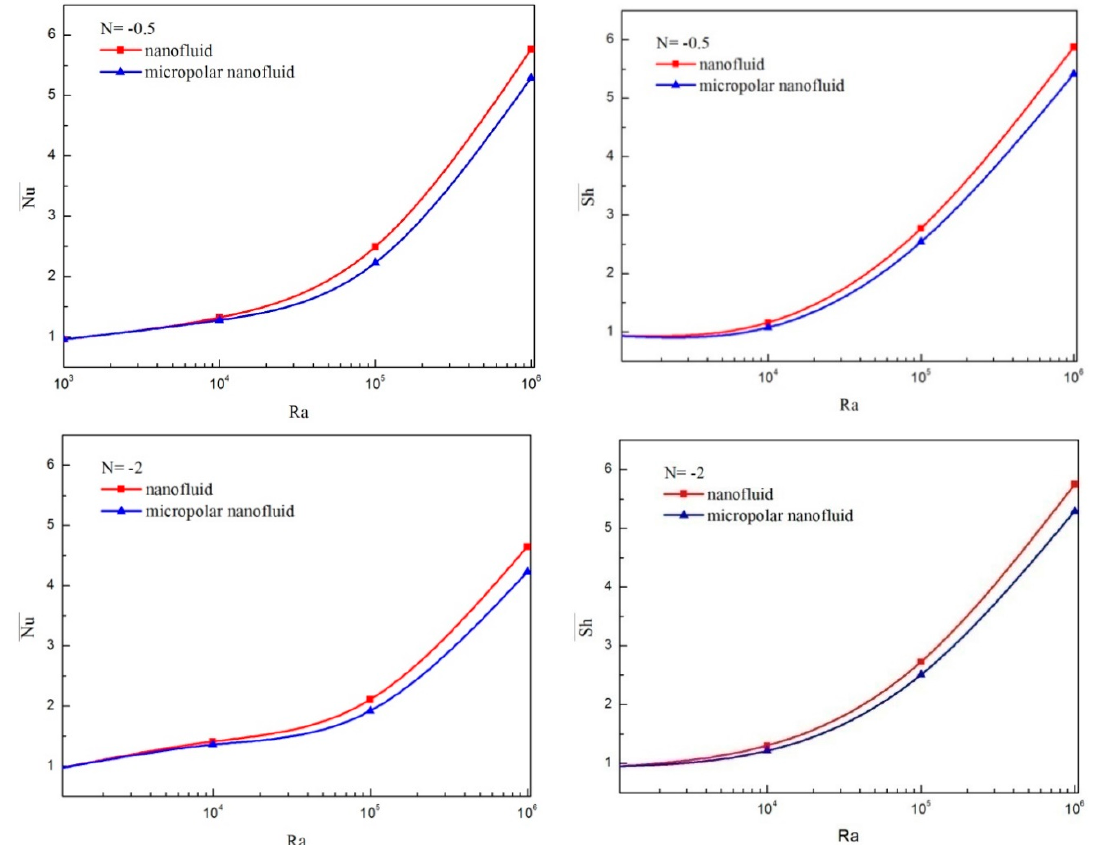
Figure 6. Variation of Nu and Sh with Rayleigh number for micropolar and non-micropolar nanofluid models for N = − 0.5 and N = − 2.